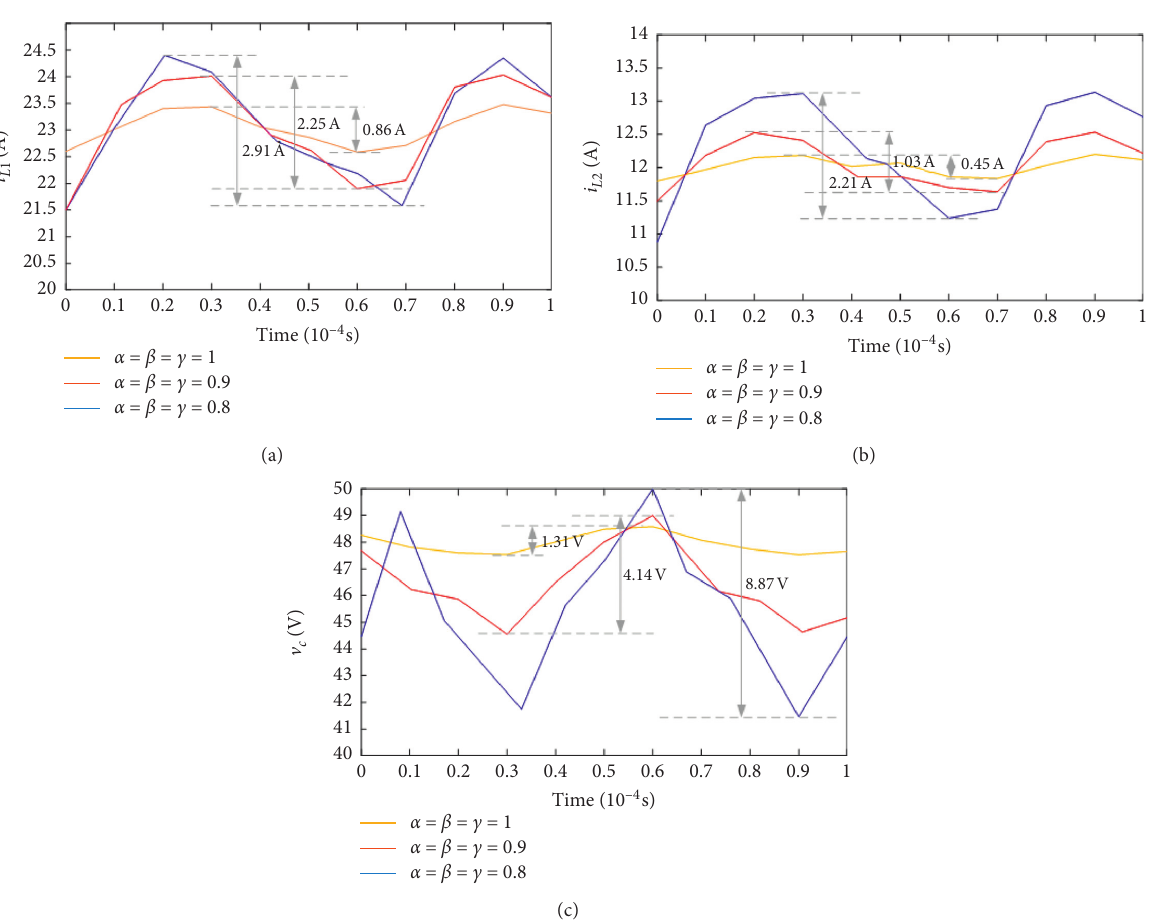
Figure 7: Simulation result of fractional-order model of equivalent dual-switch Boost converter: (a) inductor L1 current; (b) inductor L2 current; (c) output voltage.